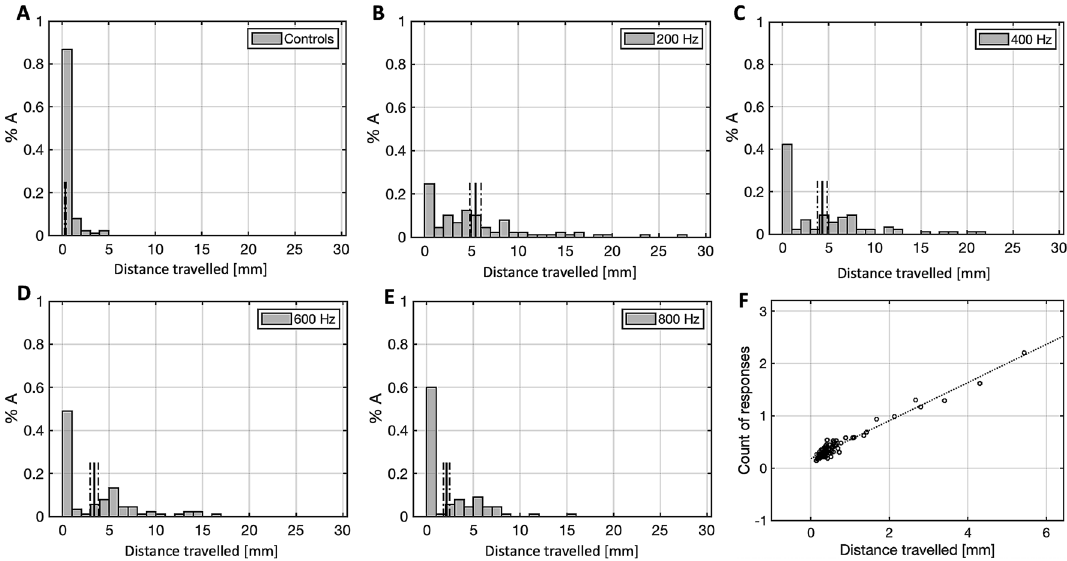
Figure 1. A correct version of the original Figure